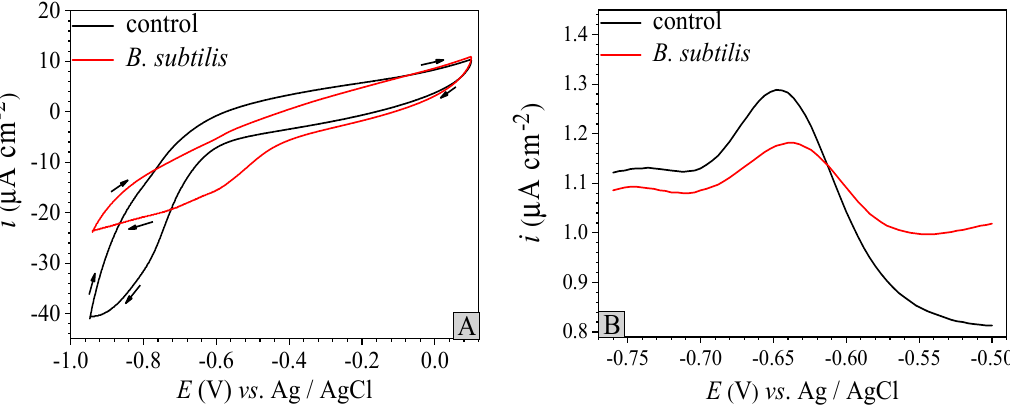
Figure 6. CV curves ( A ) of the control group and B. subtilis presence group at 48 h, DPV curves ( B ) of the control group and B. subtilis presence group at 48 h.